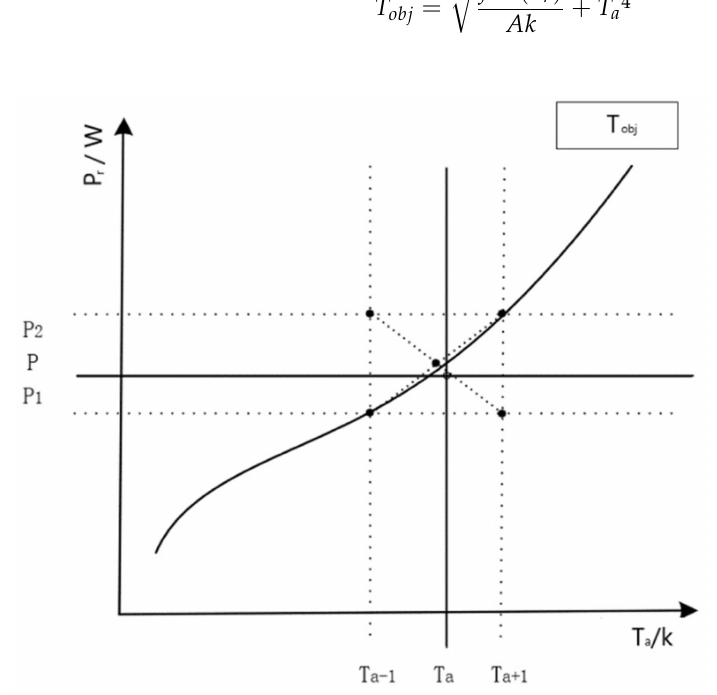
Figure 6. Binary lookup table of target object temperature (inputs are p r , T a ).